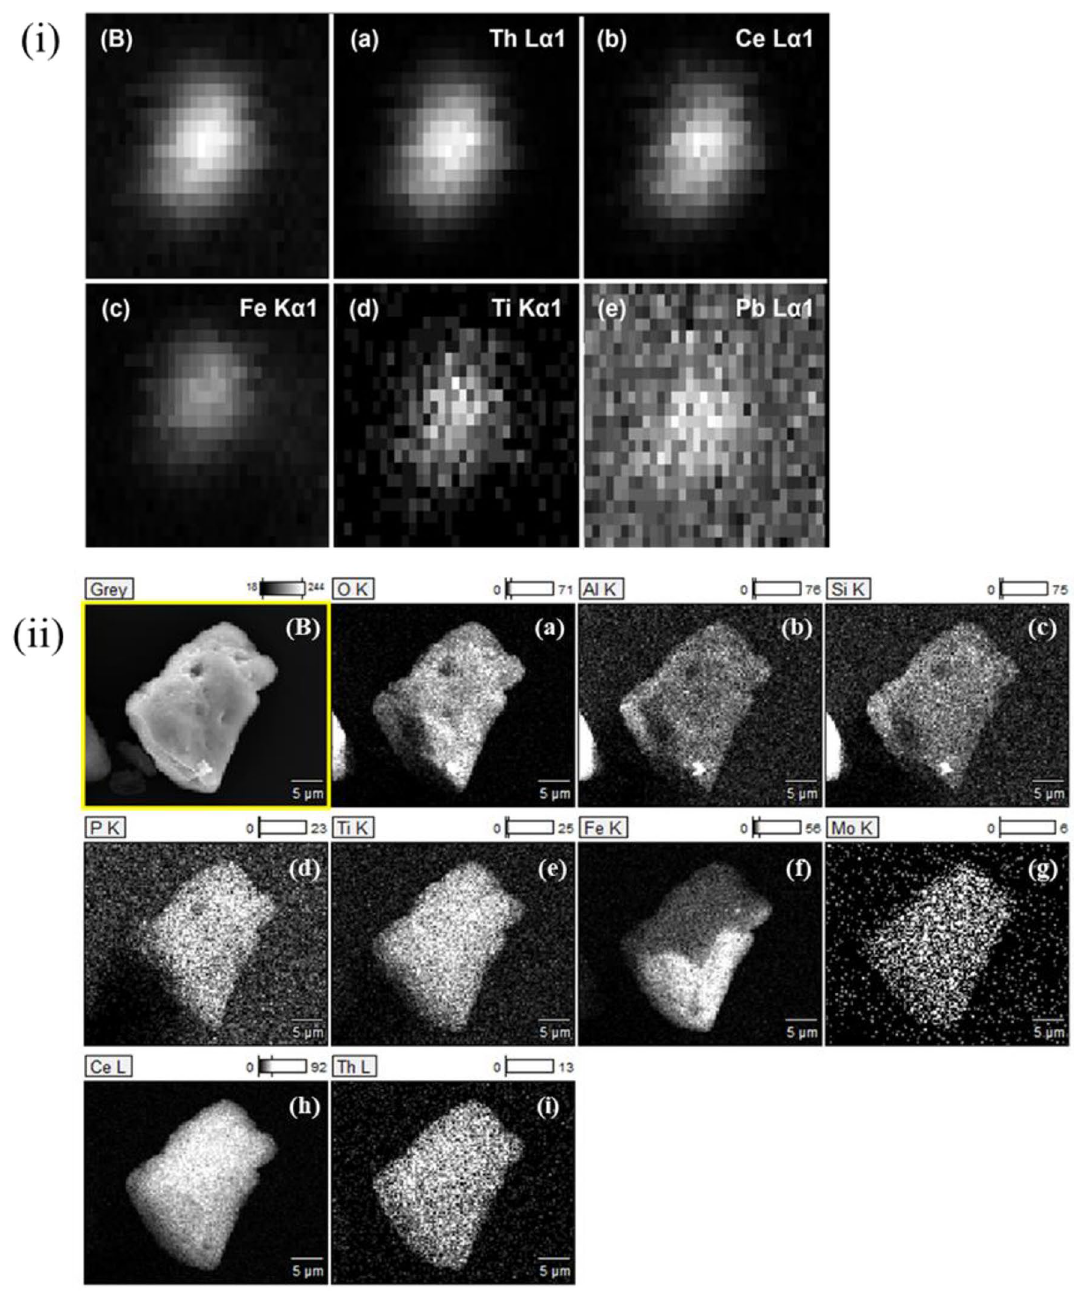
Figure 4. (i) µ-XRF maps of the Th-Ce-oxide particle ( B ) showing the total fluorescence and the fluorescence lines of Th ( a ), Ce ( b ), Fe ( c ), Ti ( d ), and Pb ( e ) in greyscale (maps: 107.5 µm in width, 55 µm in height). (ii) SEM image of particle ( B ) and SEM–EDX elemental maps for O, Al, Si, P, Ti, Fe, Mo, Ce, and Th ( a–i ) of the Th-Ce-oxide particle in